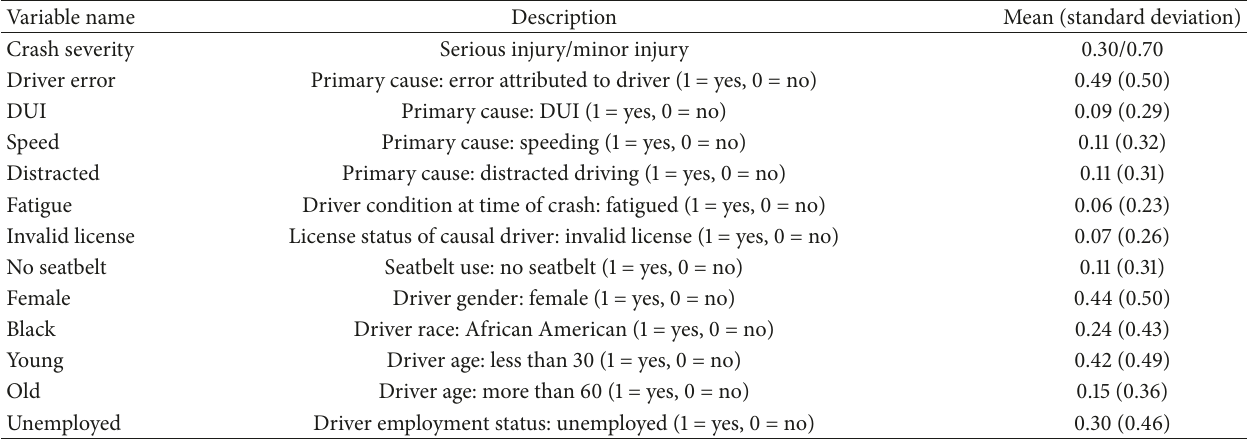
Table 1: Summary statistics of the variables used for model